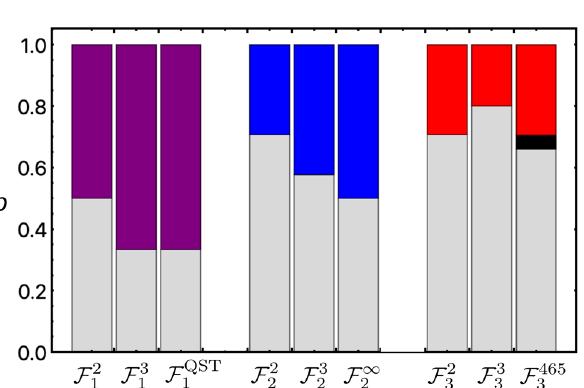
Figure 5. Bound of inequality violation for the quantum correlations of entanglement ( F n 1 ), steerability ( F n 2 ) 2, 3 are considered, while the F ∞ and Bell nonlocality ( F n 3 ). The number of measurement settings n k value = QST is estimated from infinite measurement settings, and F k is quantified by QST. Purple, blue and red colored regime represents the bound of the p mixture parameter, above which the state is certified as entanglement, steerable, and Bell nonlocal, respective. Grayed regimes denote the presence of LHS model. Note the blacked regime refers to the inconclusive regime for Bell